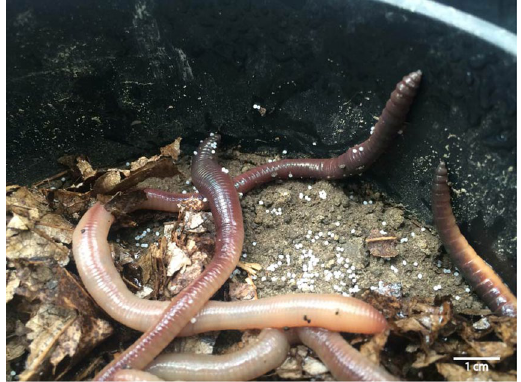
Figure 4. Polyethylene (PE-1; 710–850 μ m) microplastic particles adhering to the skin of two earthworms. Picture taken during the harvest of the